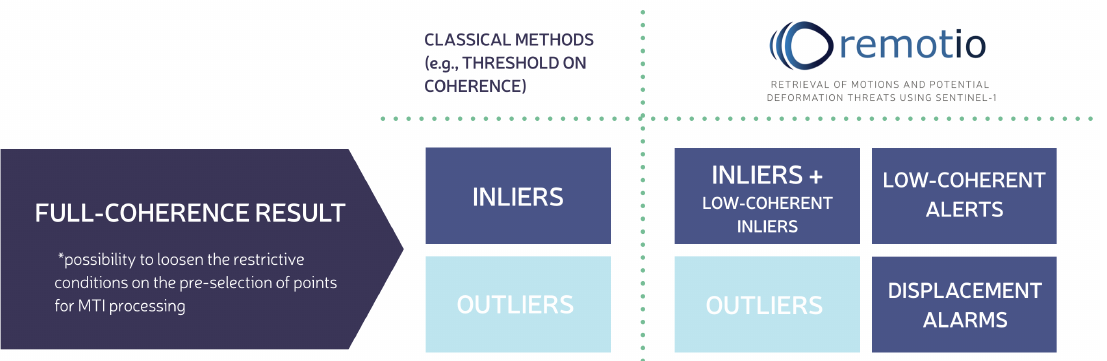
Figure 8. Higher-order products for final MT-InSAR analysis provided by remotIO’s decision-support